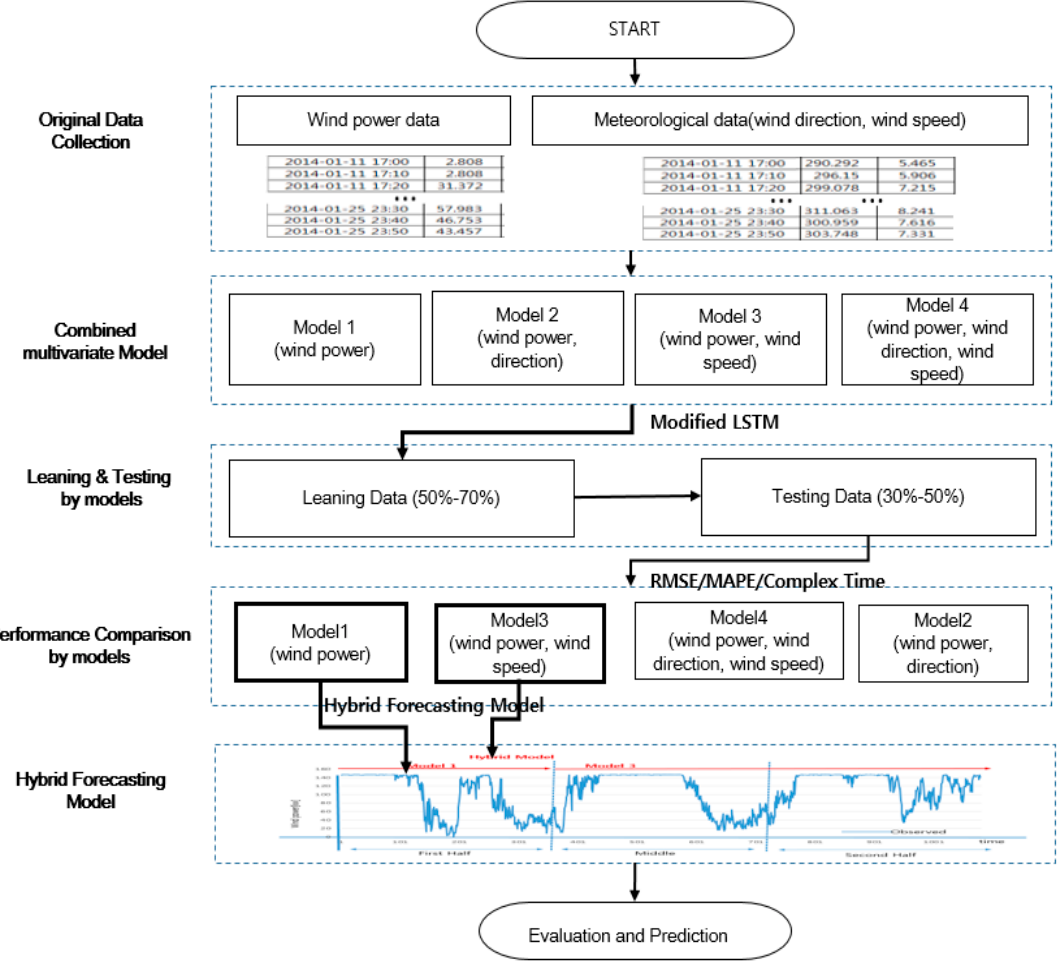
Figure 3. Flowchart of the proposed approach.